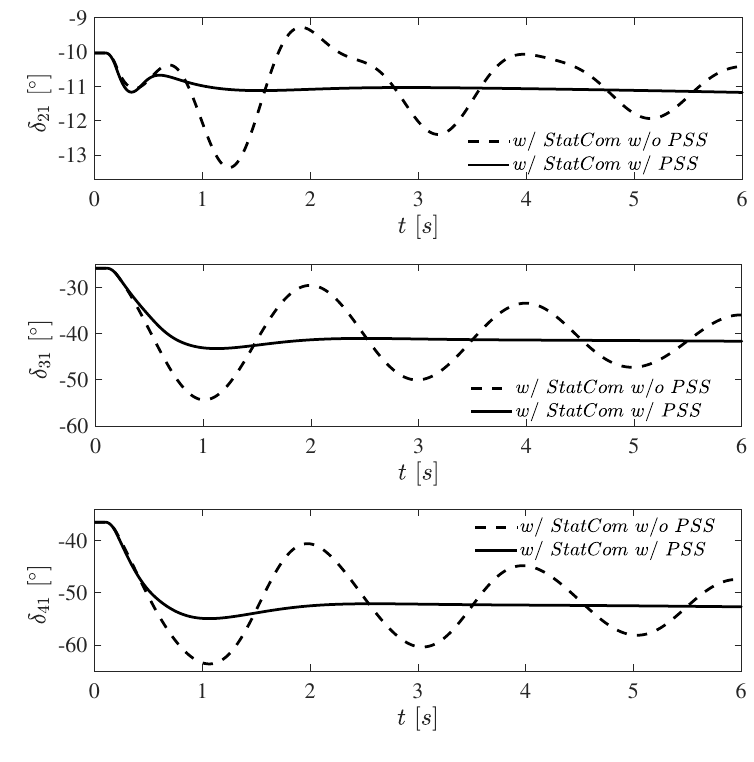
Figure 8. Angular difference of each machine with respect to number one, case 2. The angular difference of machines respect to number one are presented in Figure